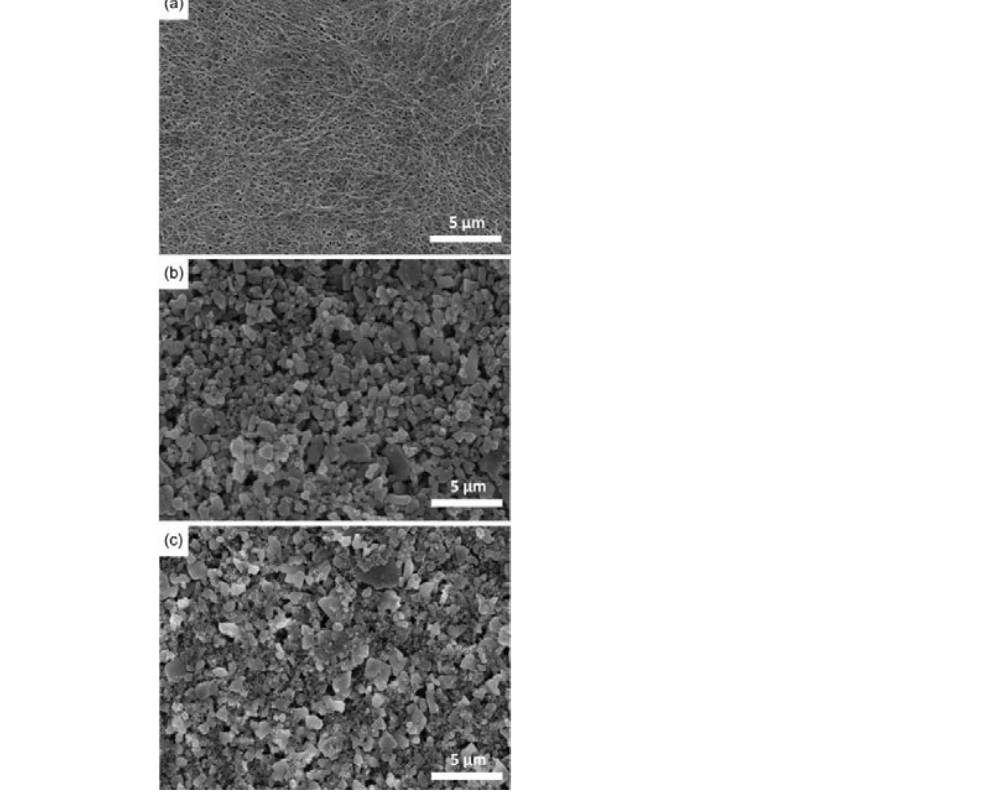
Figure 4. SEM images of the surfaces of ( a ) bare PE separators, ( b ) SC-CCS containing Al 2 O 3 , and ( c ) DC-CCSs.